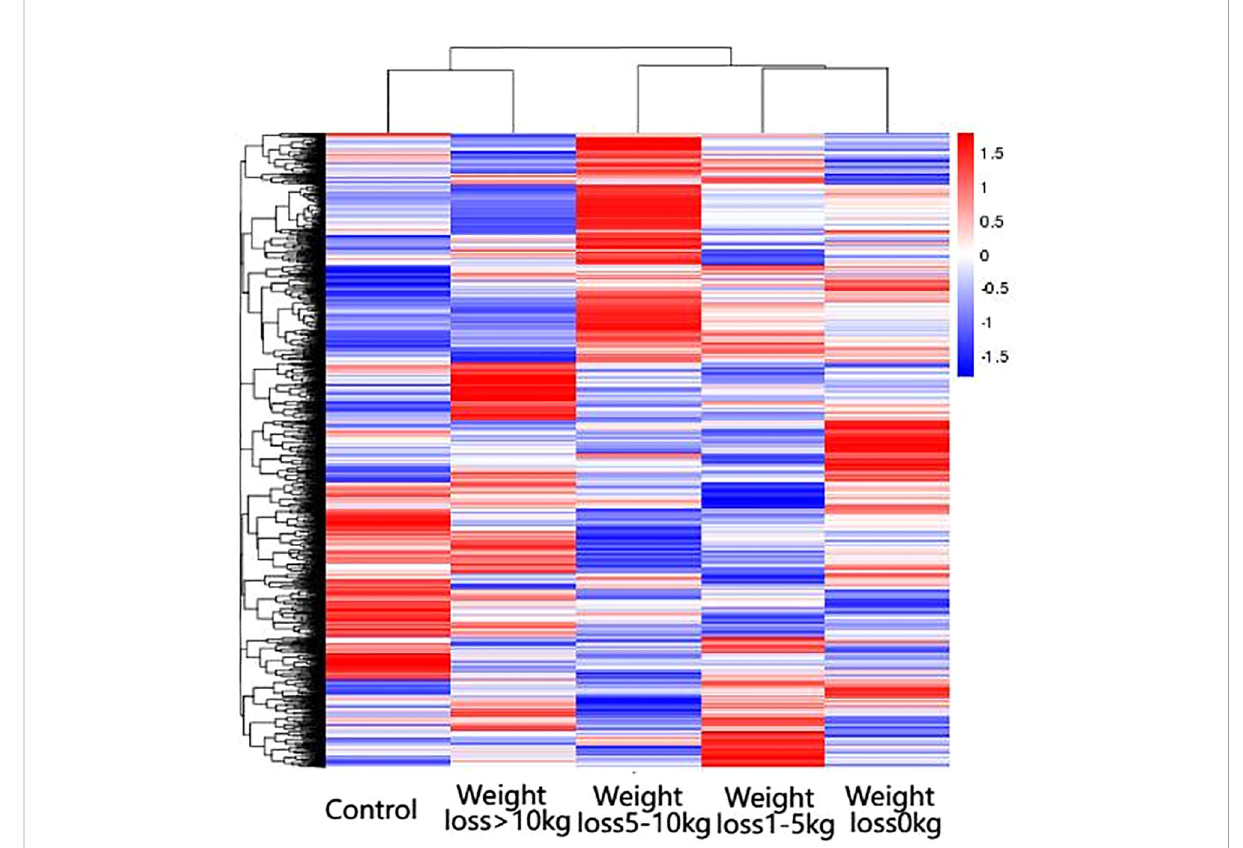
FIGURE 3 Results of differential gene clustering. Horizontal coordinates are groups, vertical coordinates are normalized values of differential gene FPKM, horizontal comparison, expression of the same gene in samples from different groups, red represents high expression, blue represents low